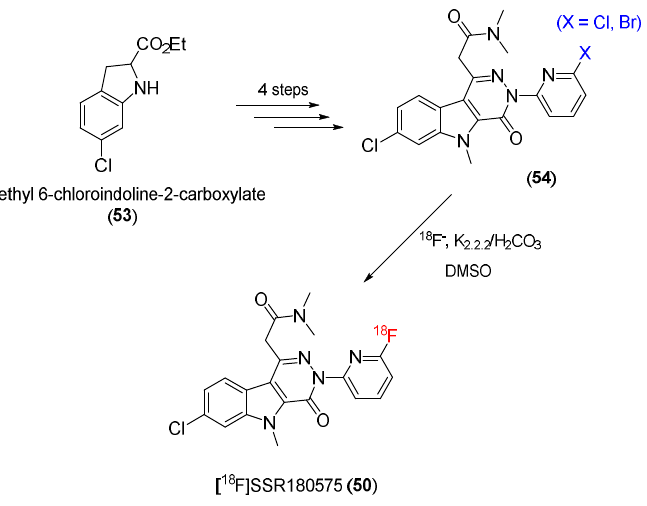
( 52 ) Figure 7. Structures of TSPO ligands containing pyridazinoindole. Manning and co-workers developed 7-chloro-N,N-5-trimethyl-4-oxo-3(6-[ 18 F]fluoropyridin-2-yl)-3,5-dihydro-4H-pyridazino [4,5-b]indole-1-acetamide, or [ 18 F]SSR180575 ( 50 ), as a potential TSPO ligand [106]. Using